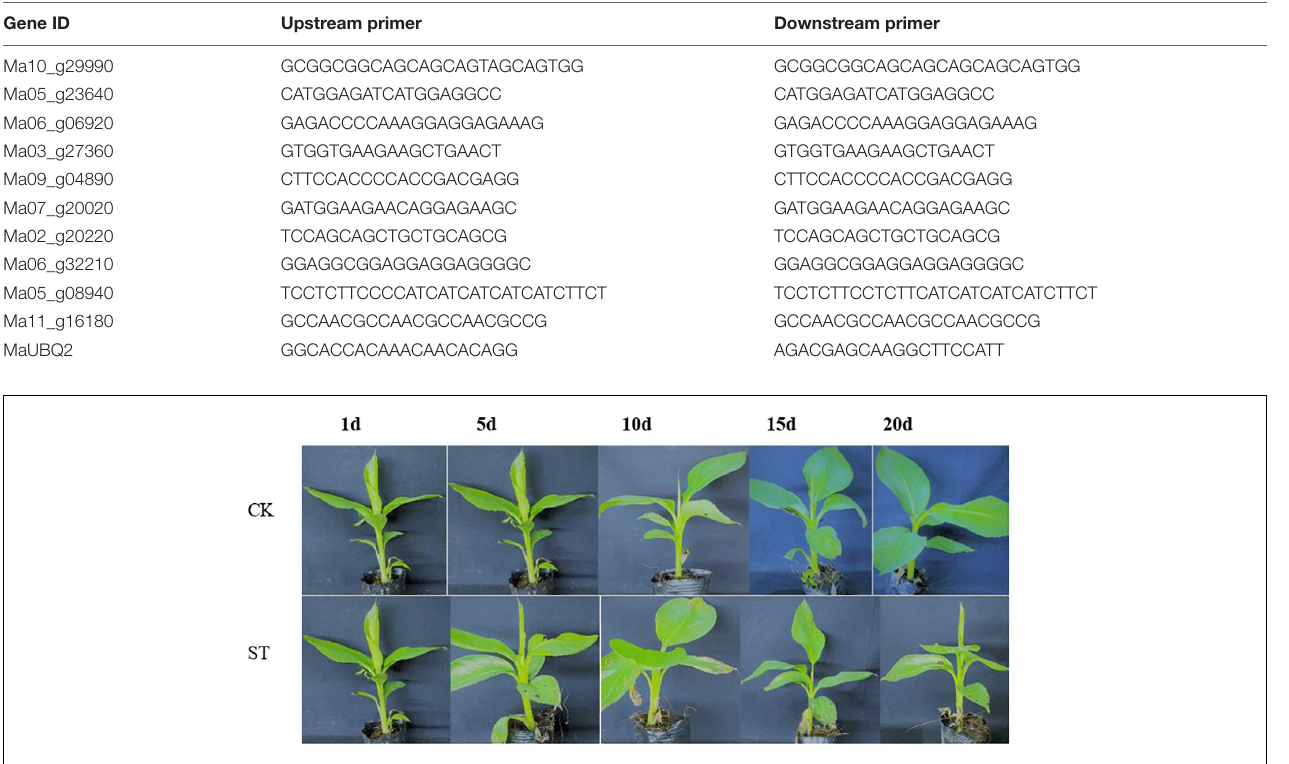
FIGURE 1 | Effect of NaCl treatment on BD banana seedling growth. Five leaf stage banana seedlings were subjected to 60 mM NaCl treatments and photos were taken at different time points.